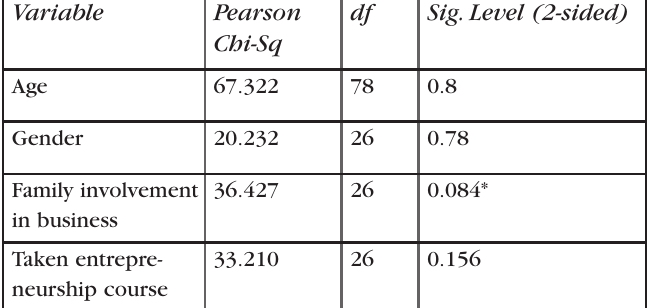
Table 7. Chi-square Test for Age, Gender,